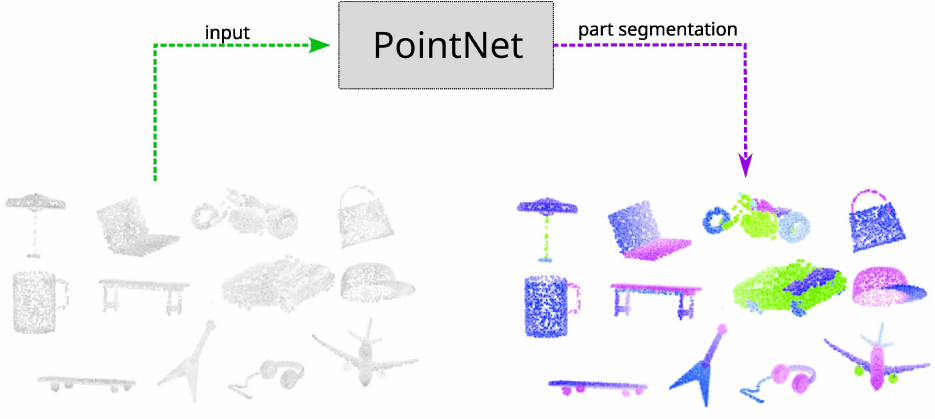
Figure 3. Example of using PointNet [78] for performing part segmentation directly on input point